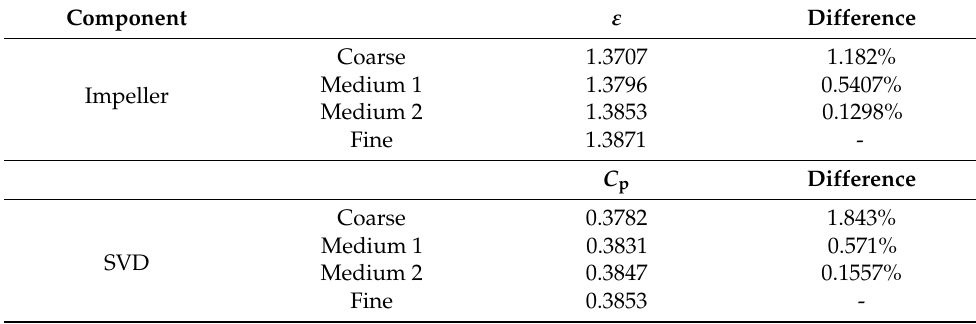
Table 2. Research on grid independence for impeller and SVD domain. Component